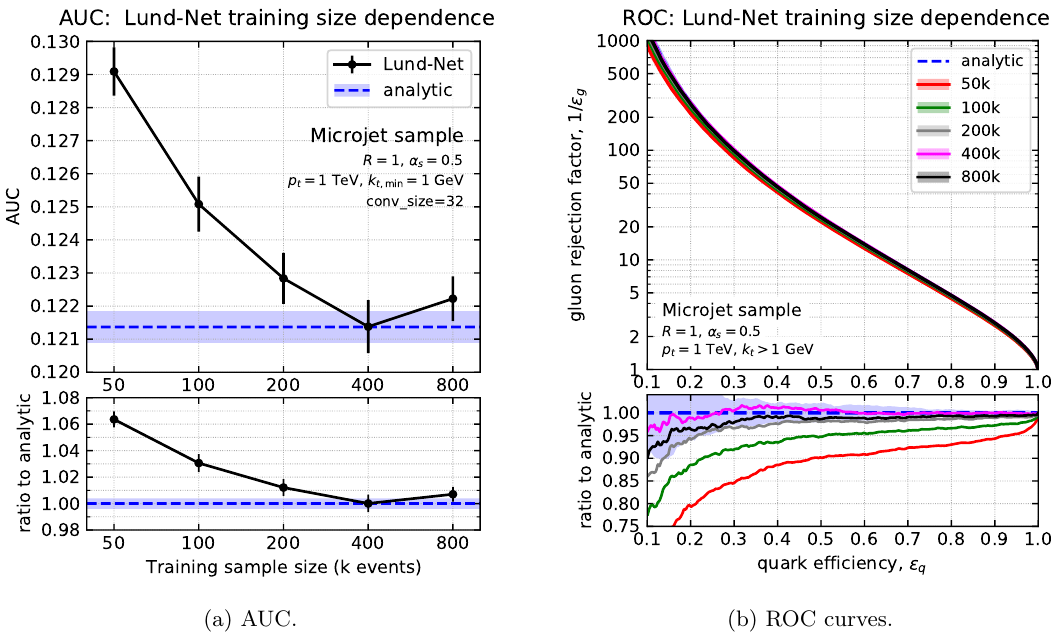
Figure 5. Convergence of the ML-based Lund taggers as a function of the training sample size for the AUC (a) and ROC curve (b). The ML testing phase is always performed on the same 100k events and the shaded band around the analytic results is the fluctuations across different samples of 100k events. The optimal performance is reached for training sample sizes of 400k events and